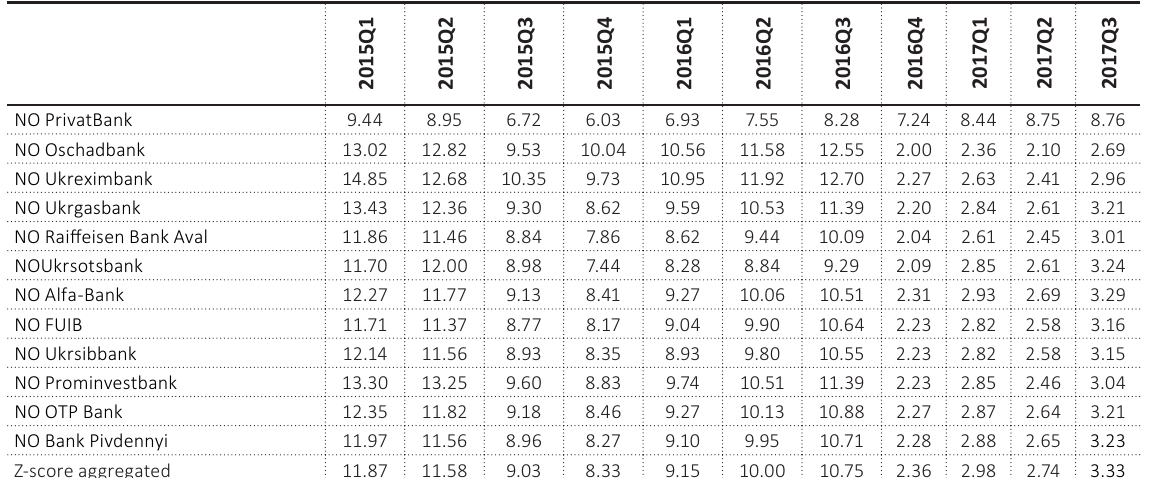
Sources: Authors’ estimation